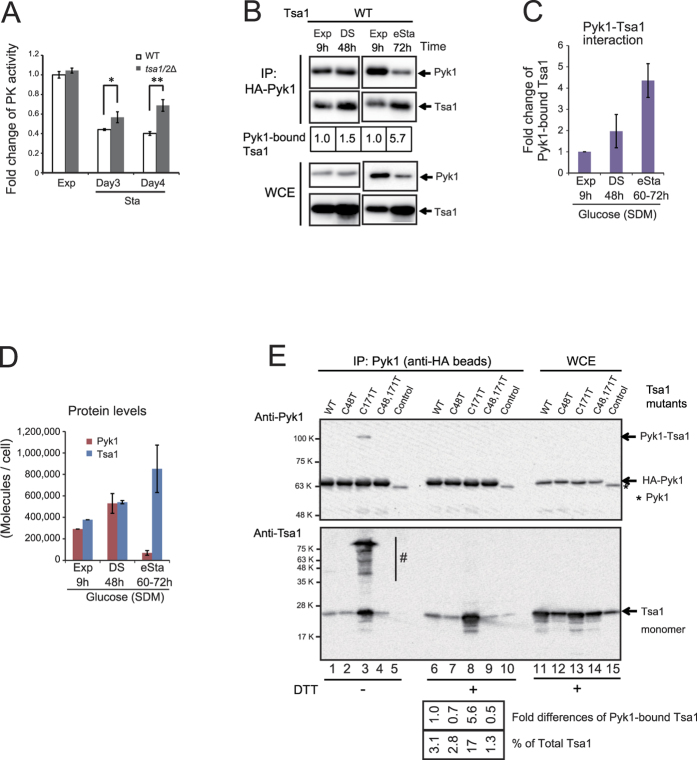
Role of Tsa1 on Pyk1 during the early stationary phase in glucose medium (SDM).(A) Fold changes in PK activity were determined in lysates (N = 3) that were prepared from wild type and tsa1/2∆ cells from the exponential phase (Exp) and stationary phase (Sta: after 3 days and 4 days of culture) in SDM. “*” and “**” indicate p values of 0.046 and 0.0049, respectively. (B) A pull-down experiment of Tsa1 bound to HA-Pyk1 in early stationary phase cells in SDM. The growth phase and culture time is indicated. A diauxic shift (DS, 48 h), and occurrence of the early stationary phase (eSta) at 72 h (see Figure Supplement 3 and below). (C) Fold changes in Tsa1 bound to Pyk1 in cells growing in SDM determined from four different experiments are shown. (D) The molecules/cell of Pyk1 and Tsa1 in cells propagating in SDM were estimated based on the data shown in Fig. 3D and quantitation of proteins in WCE from each culture. The data are the averages of four independent experiments. (E) Requirement of cysteine residues of Tsa1 for the interaction with Pyk1. A pull-down experiment using the indicated Tsa1 mutants bound to HA-Pyk1 as in (B). HA-Pyk1 was immunoprecipitated from the lysate (67 μg/lane and 111 μg/lane for HA-Pyk1 and Tsa1, respectively; lanes 1 to 10), and the whole cell extract (1 μg for Pyk1 and 0.5 μg for Tsa1; lanes 11 to 15, WCE) was separated by SDS-PAGE. BY4742 cells expressing endogenous Tsa1 and Pyk1 were used as a control. An asterisk indicates endogenous Pyk1 without a tag, which represents the nonspecific background for IP. The band intensity suggests that the IP efficiency of Pyk1 was 3.5-5.3%. The estimated levels (% of total Tsa1) and fold differences in Pyk1-bound Tsa1 are reported. Multiple slowly migrating bands (indicated as “#” in the lower panel, lane 3) were estimated at >70% of the total Tsa1.